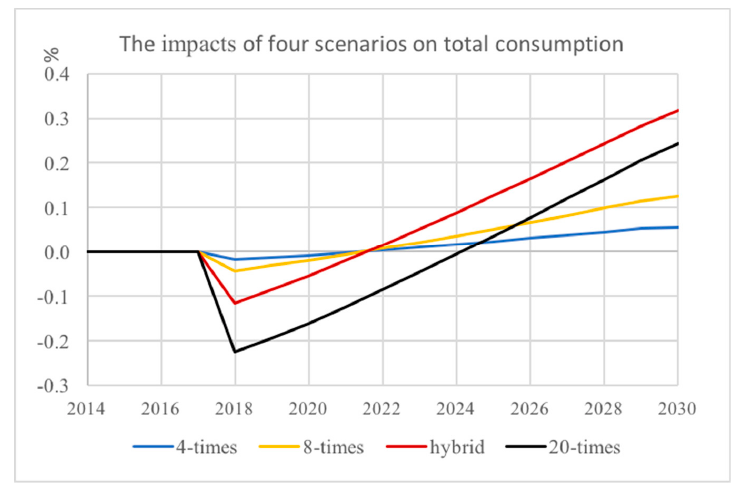
Figure 2. The impacts of four water pollution tax policy scenarios on total consumption (base year price).